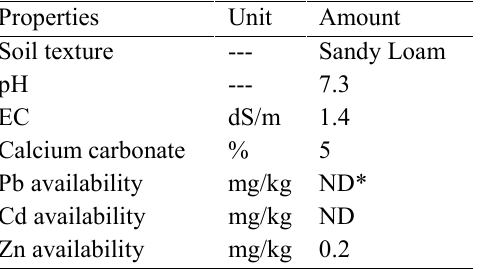
Table 1. Selected physicochemical properties of studied soil